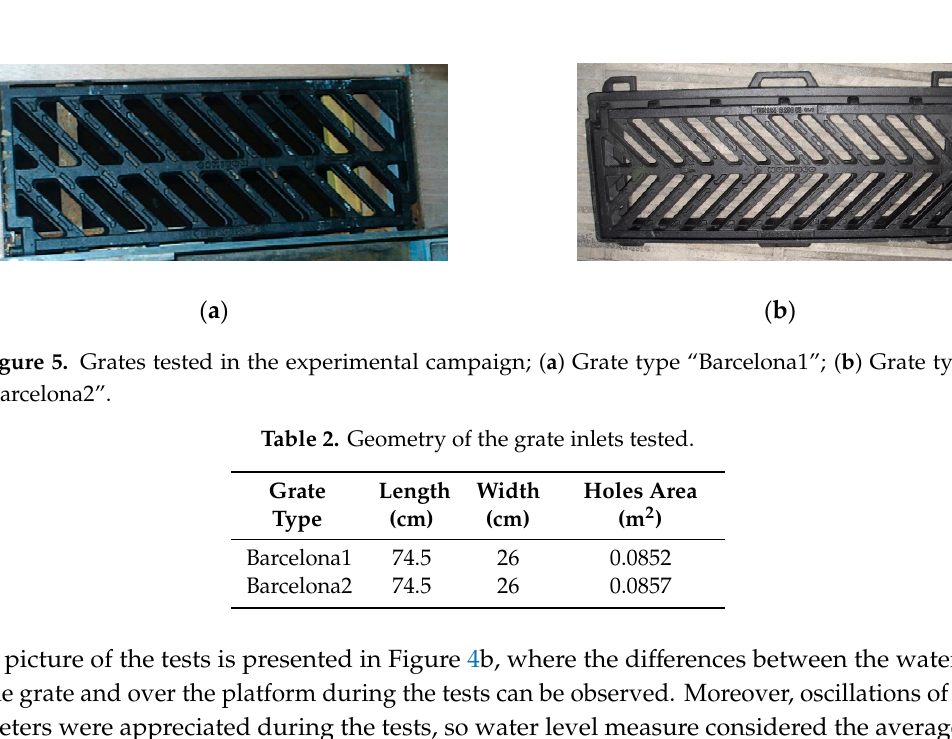
Figure 4. ( a ) Structure to support the limnimeter to read water levels over the grate; ( b ) Test of 40 L/s, 0% longitudinal slope for the Barcelona1 grate.